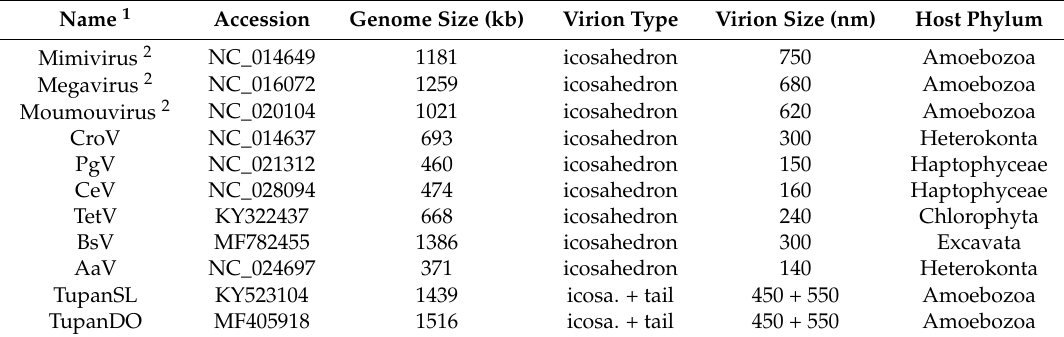
Table 1. Physically isolated Mimiviridae with fully sequenced